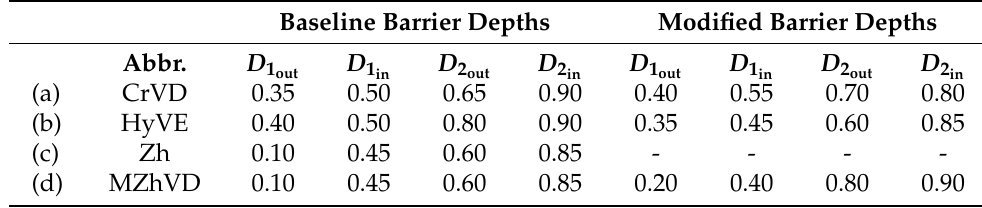
Table 2. Illustrative depth coefficient table for Figure 5. Baseline Barrier Depths